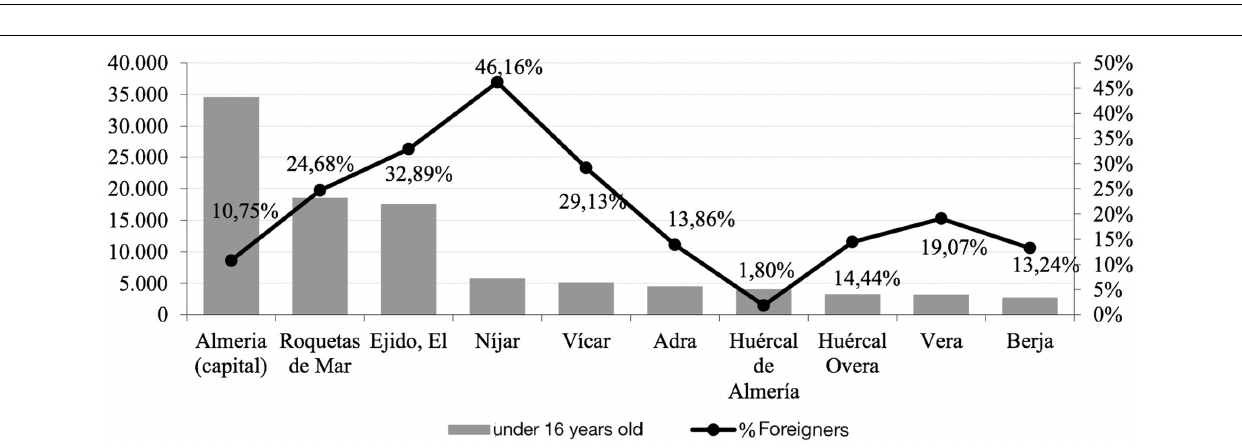
FIGURE 4 | Municipalities in Almeria with more young people under 16 years (main axis) weight of foreigners on total (secondary axis). Año 2014. Source : INE.